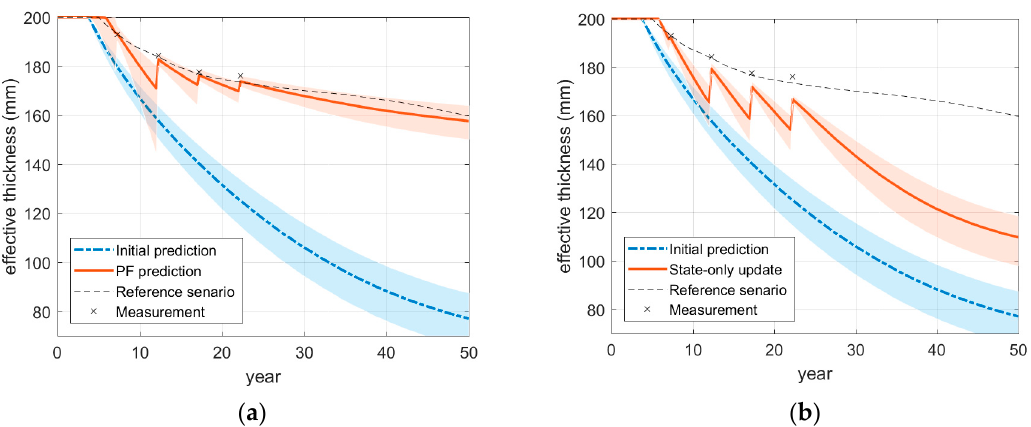
Figure 10. Monitoring and prediction of effective thickness via particle filter: ( a ) Particle filter with parameter updating (proposed); ( b ) Particle filter without parameter updating.